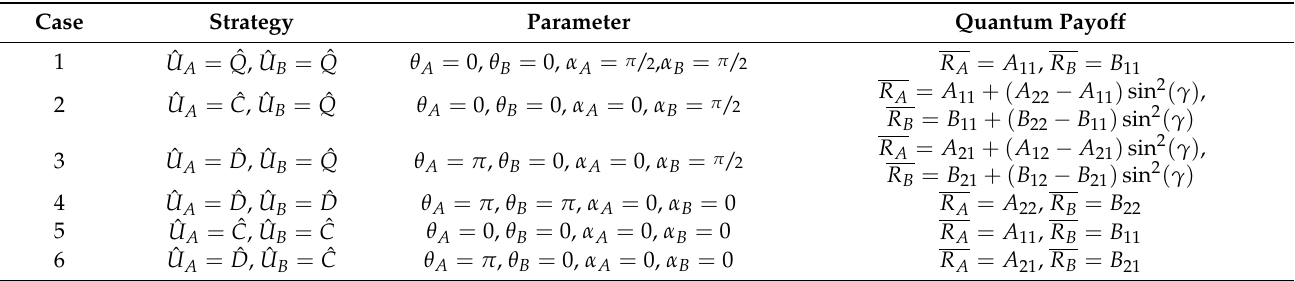
Table 2. Quantum payoffs by